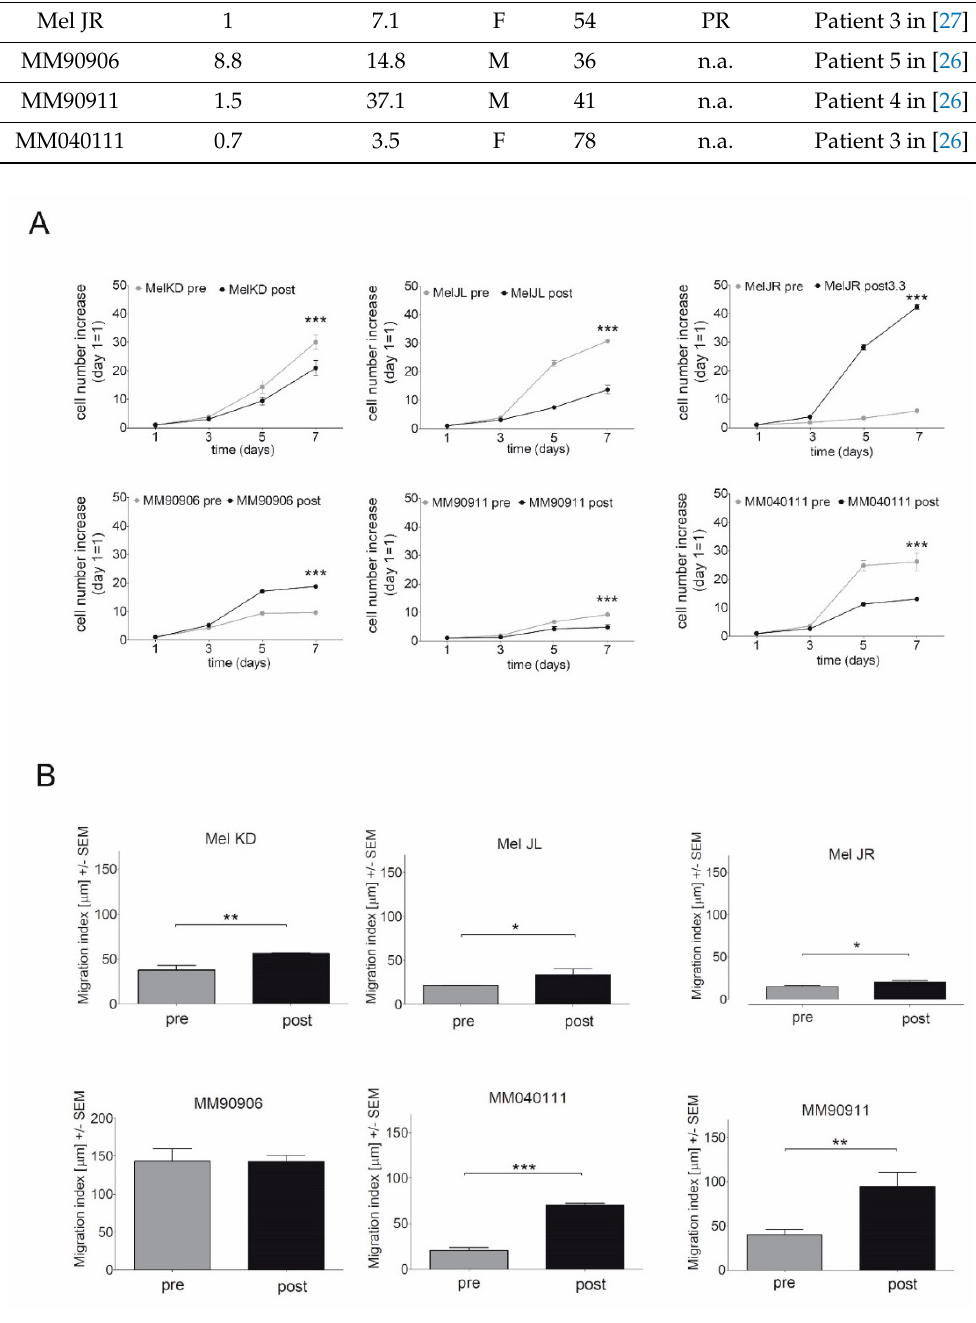
Figure 1. Proliferation and migration of melanoma cells. ( A ) Relative proliferation rate of cell line pairs (mean values +/ − SEM). ( B ) Migration index is equivalent to the average net displacement of the cells in 20 h (mean values +/ − SEM) (* p ≤ 0.05, ** p ≤ 0.01, *** p ≤ 0.001).